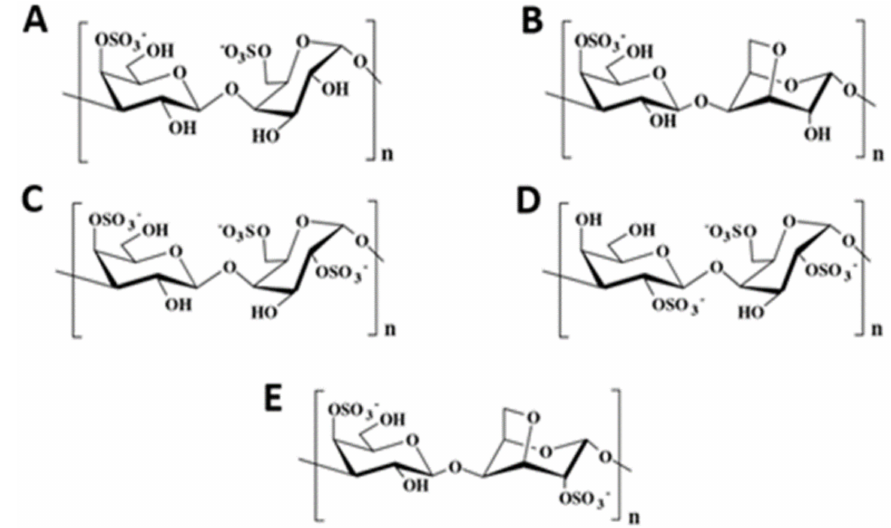
Figure 8. Structures of ( A ) µ -carrageenans, ( B ) κ -carrageenans, ( C ) ν -carrageenans, ( D ) λ -carrageenans and ( E ) ι